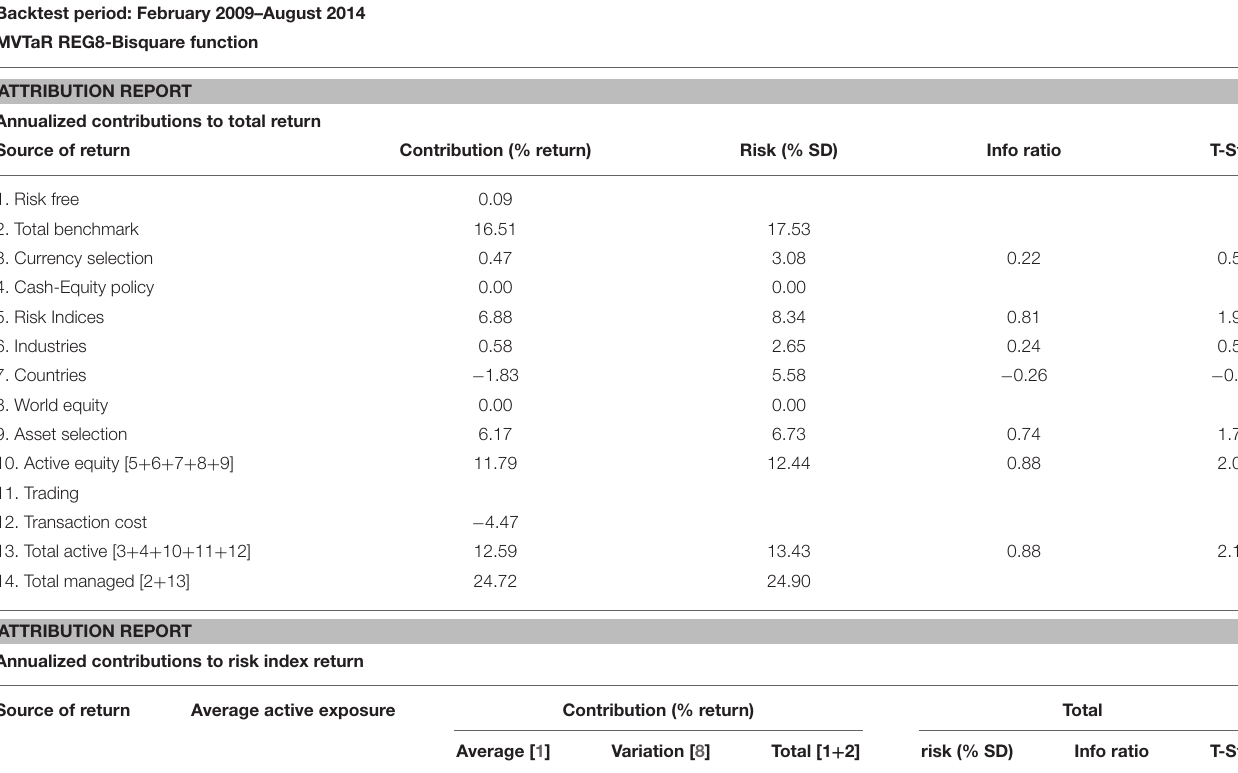
TABLE 3 | Barra attribution of regression-based